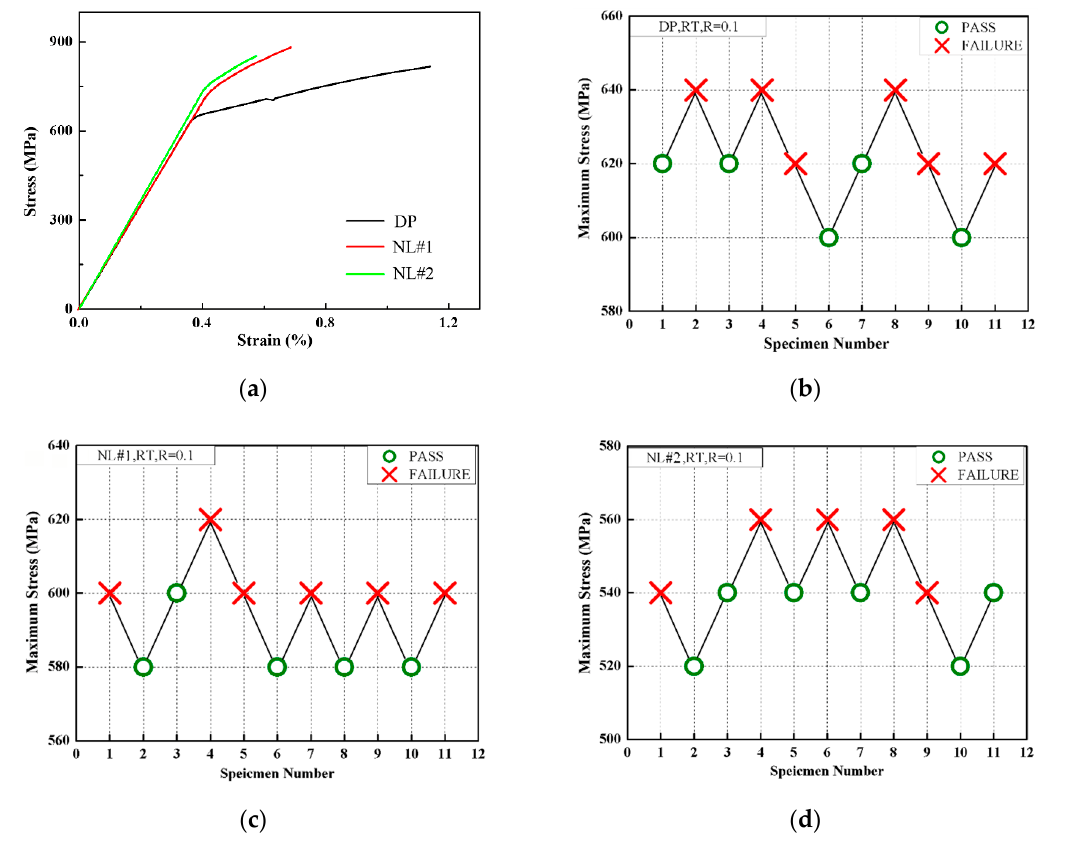
Figure 3. ( a ) Tensile stress-strain curves and Up-and-down diagrams obtained from staircase tests of different microstructural TiAl alloys: ( b ) DP, ( c ) NL#1, and ( d ) NL#2.